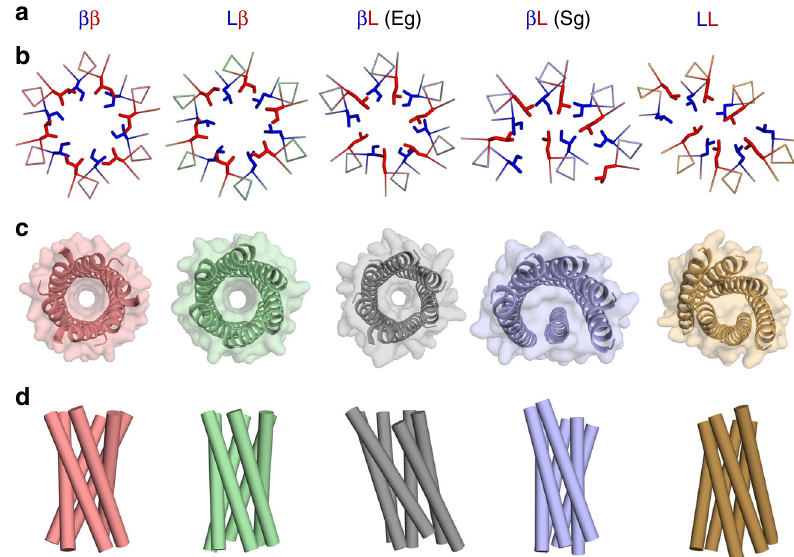
Fig. 3 Diversity of structures formed by the CC-Type2 variants with aliphatic cores. a – d Hexameric assemblies from each design class ( a ). From left to right: blunt-ended barrel, CC-Type2-II-Sg (CC-Hex3), red; blunt-ended barrel, CC-Type2-LI-Sg (CC-Hex2), green; slipped barrel, CC-Type2-IL-Eg (CC-Hex-IL), grey; slipped and collapsed structure, CC-Type2-IL-Sg, blue; and collapsed structure, CC-Type2-LL-Sg, brown. b Slices through heptad layers with side chains at a and d represented as blue and red sticks, respectively. c , d Orthogonal views of the structures viewed from the N terminus with surfaces rendered semi-transparent ( c ), and with α helices as cylinders ( d )